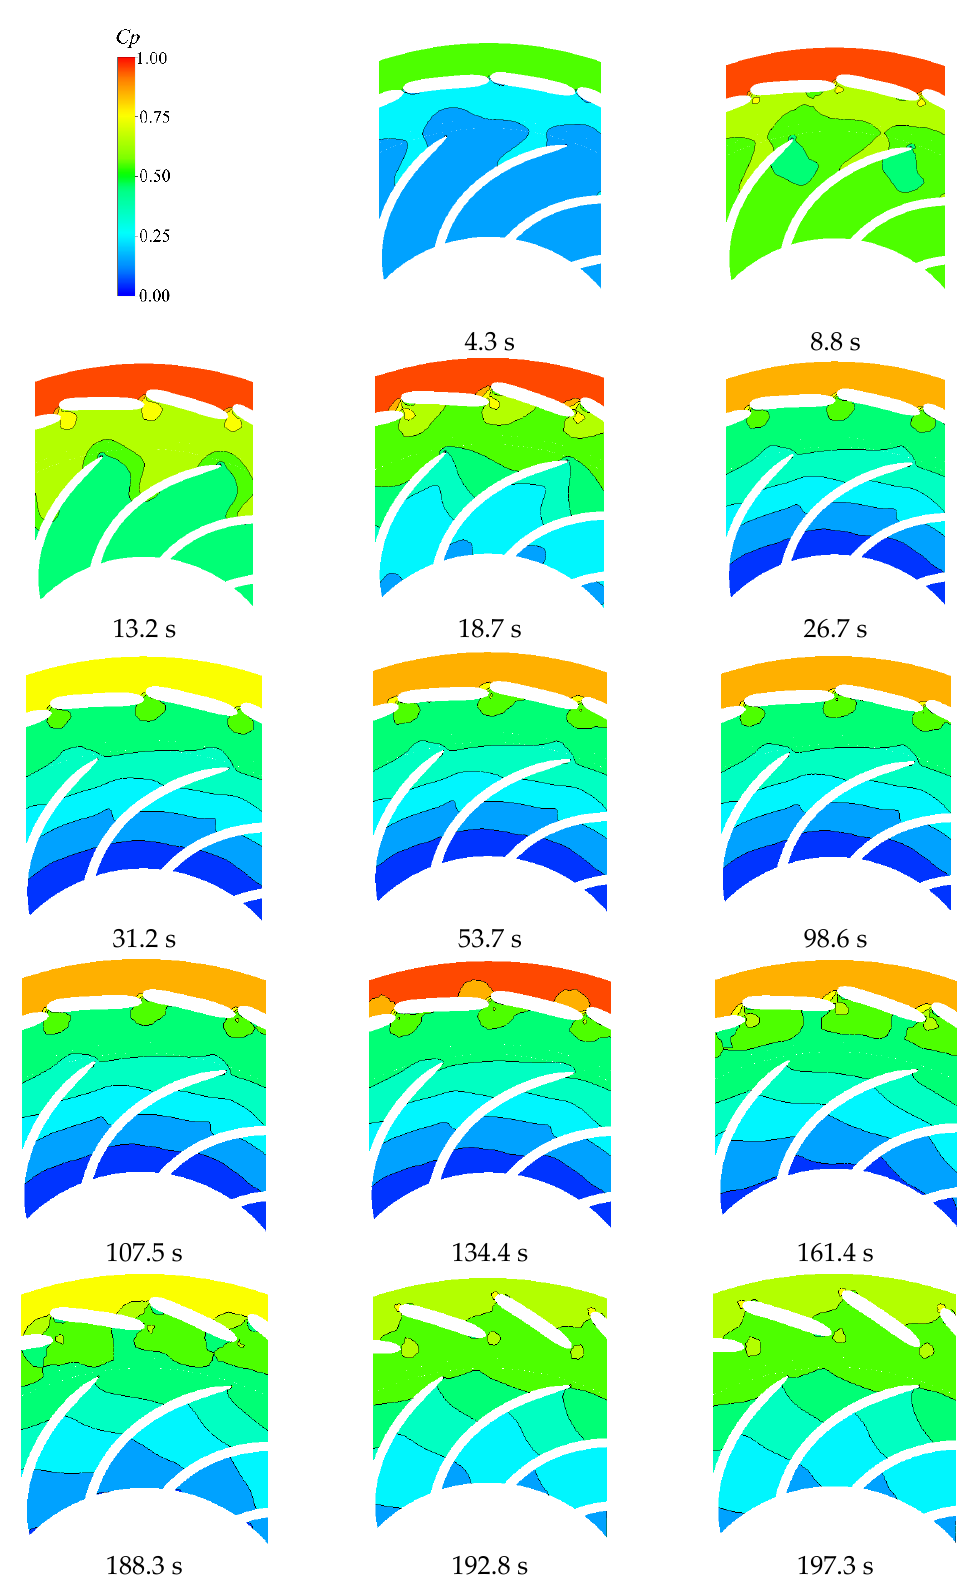
Figure 7. Pressure distribution of the critical zone during turbine start-up. Figure 8 shows the normalised velocity characteristics of the flow in the PT unit at various time points during turbine start-up. As the guide vane opening increases, the flow rate from the spiral case to the runner increases. Due to the small opening of the guide